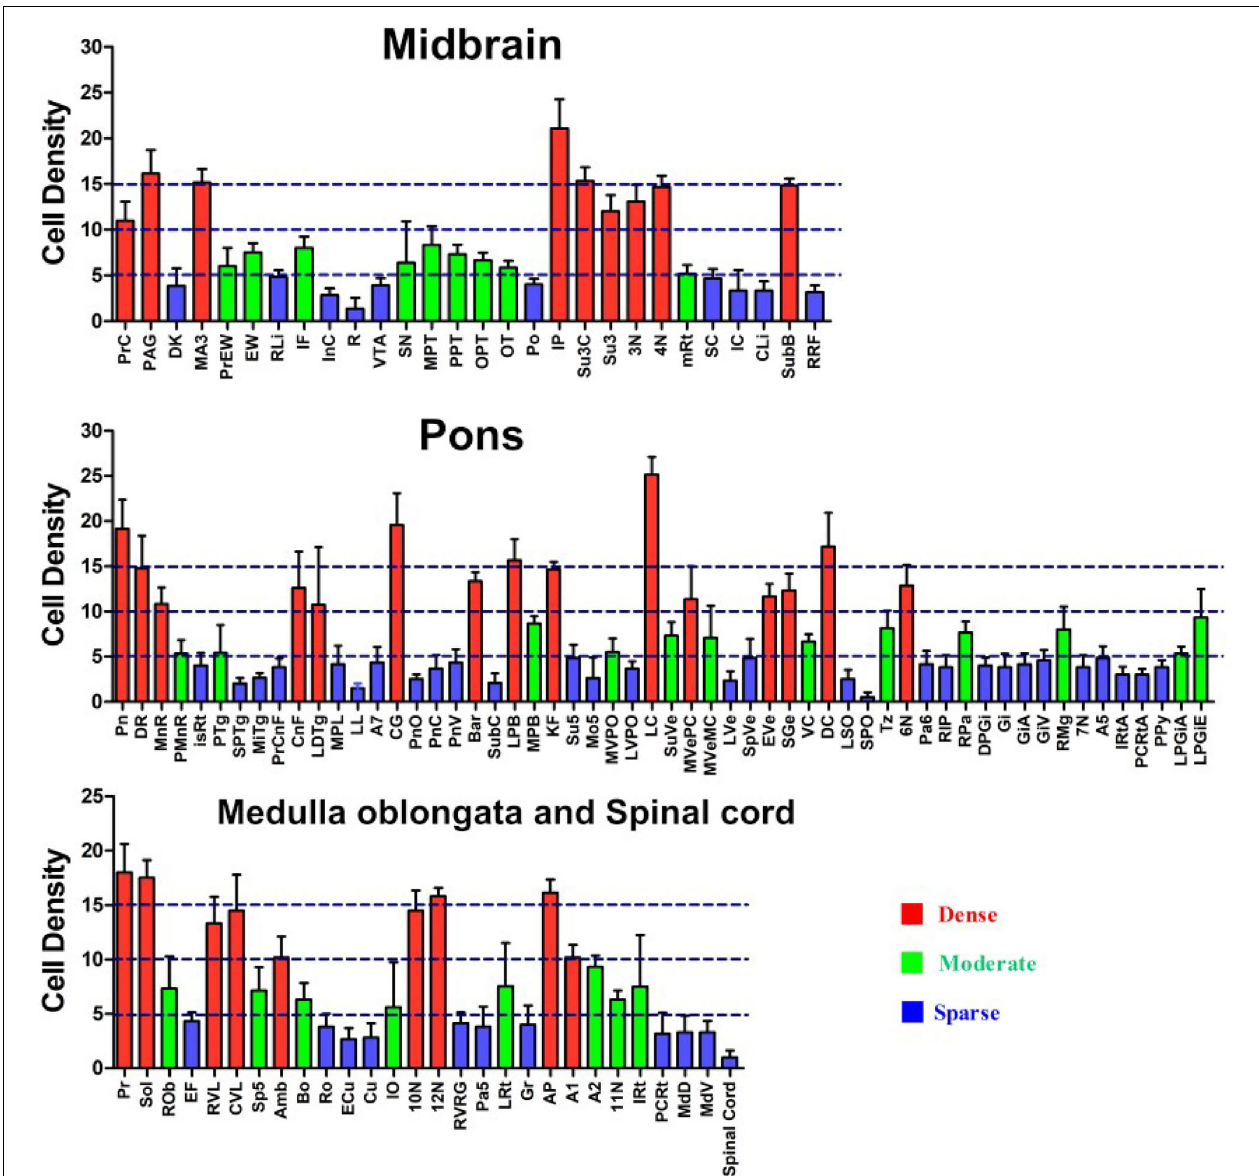
FIGURE 13 | Whole brainstem and spinal cord statistics of CB-positive cell input to the CSF-contacting nucleus (mean ± SD, n =